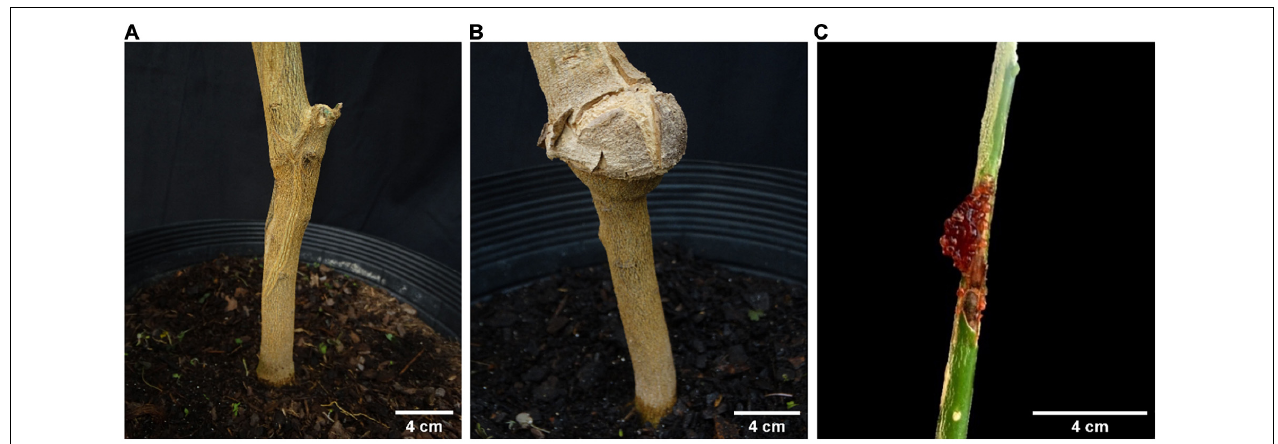
FIGURE 2 | (A) An Eremocitrus glauca × Citrus × sinensis scion propagated on ‘Rangpur’ lime as an example of good rootstock/scion compatibility between two genotypes. (B) Limonia acidissima scion propagated on ‘Rangpur’ lime showing overgrowth incompatibility at the graft union. (C) Profuse gum exudation in the graft union between ‘Valencia’ sweet orange budwood and Citrus halimii